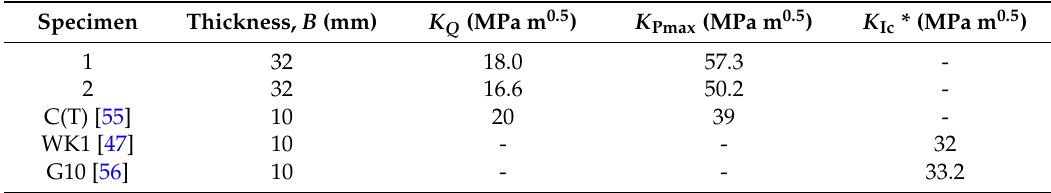
Table 6. Results of the fracture toughness tests and comparison with literature data.